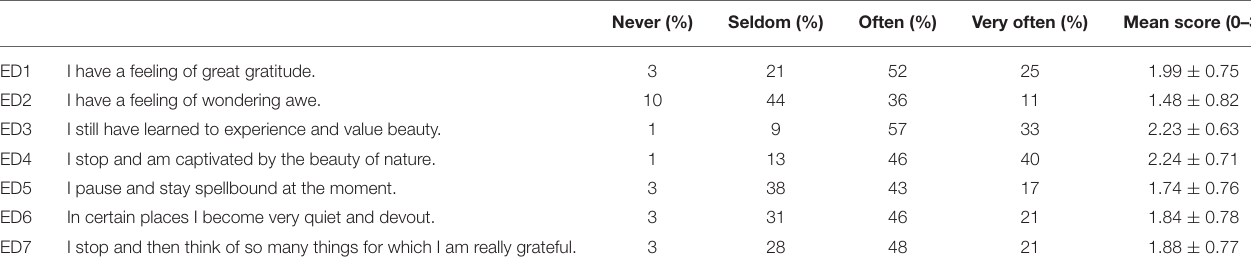
TABLE 2 | Items and response rate of the Awe/Gratitude scale.